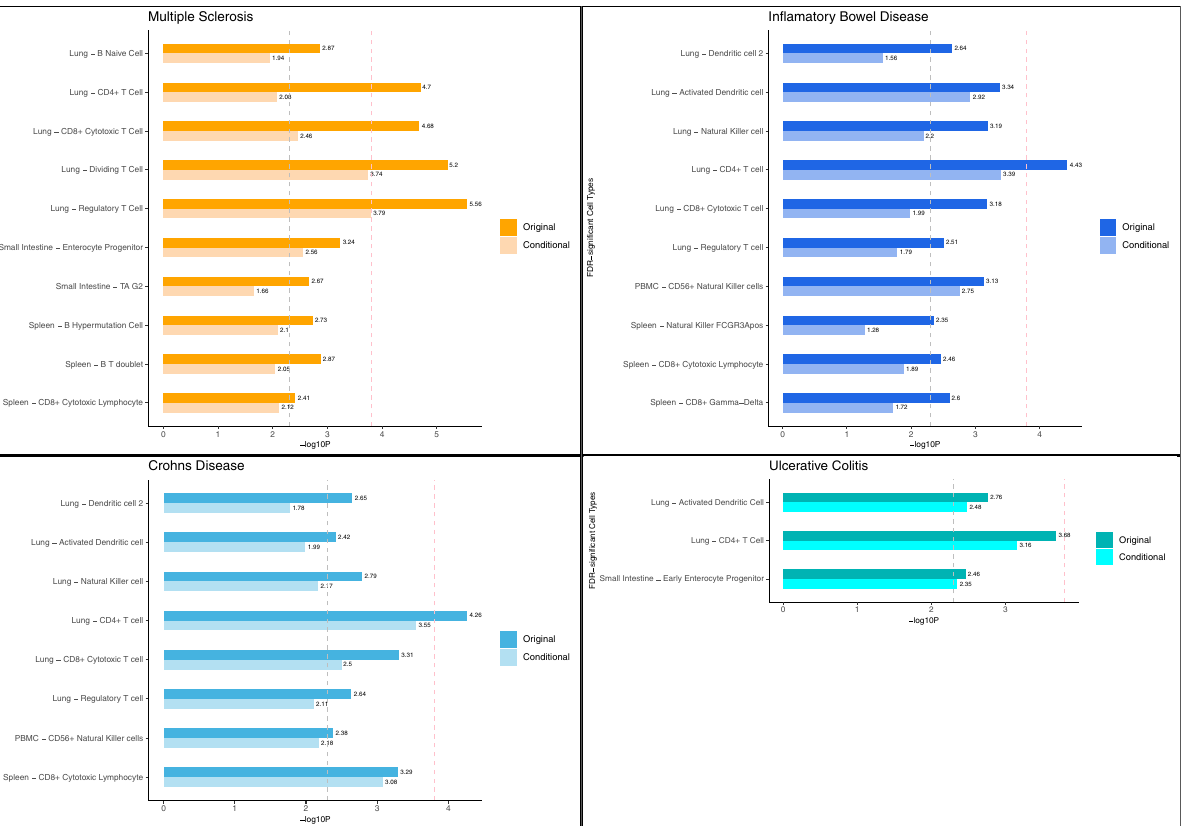
Fig. 5 Cell-type-speci fi c enrichment of single nucleotide polymorphism (SNP) heritability for multiple sclerosis (MS), in fl ammatory bowel disease (IBD), ulcerative colitis (UC) and Crohn ’ s disease (CD) in immune tissues estimated using strati fi ed linkage disequilibrium score regression (S-LDSC). Cell types are included if they showed FDR-signi fi cant enrichments in at least one disease. Negative log10 p -values of coef fi cient Z -scores for each individual test (two-tailed Z -test) are displayed on the x -axis. The grey and pink dotted lines represent the FDR threshold <5% and Bonferroni corrected threshold for multiple comparisons, respectively. Original indicates results from S-LDSC analyses adjusted for the baseline model and the set of all genes. Conditional indicates results from conditional S-LDSC adjusted for the baseline model, the set of all genes, the set of genes speci fi cally expressed in the three non-focal tissues (e.g. small intestine – terminal ileum, lung and whole blood in analyses of spleen) and the set of genes highly expressed in other FDR-signi fi cant cell types of the same tissue and same disease (e.g. spleen: B/T doublet and spleen: CD8 + cytotoxic lymphocytes in analyses of spleen: B hypermutation cells). Source data are provided with this